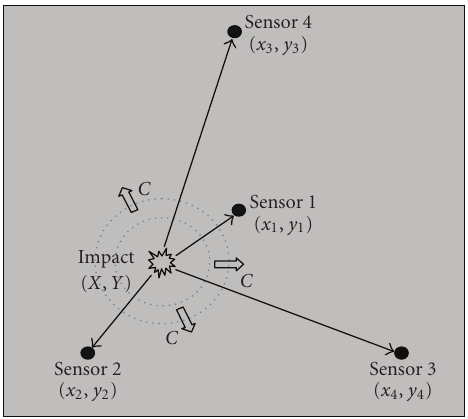
Figure 4: Nomenclature for the 4-sensor algorithm to evaluate the impact